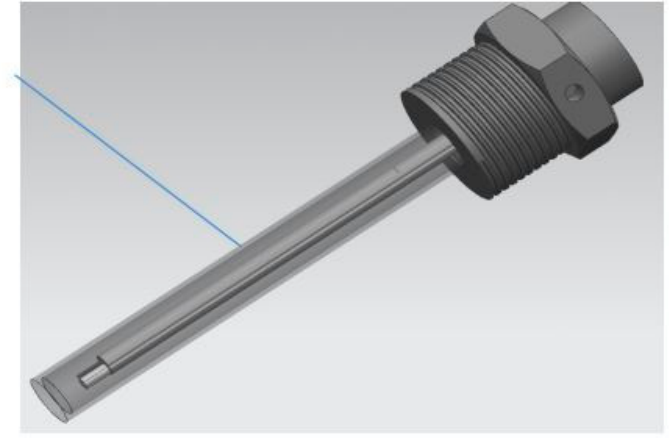
Figure 4. Integrated light heating and temperature sensing unit.